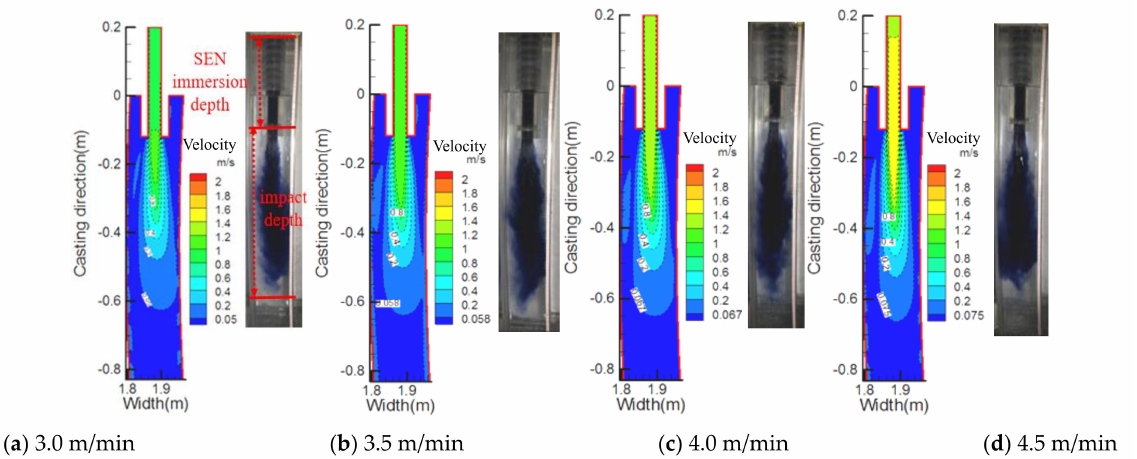
Figure 11. Comparison of numerical simulation and physical experiment of mold flow field results at different casting speeds.